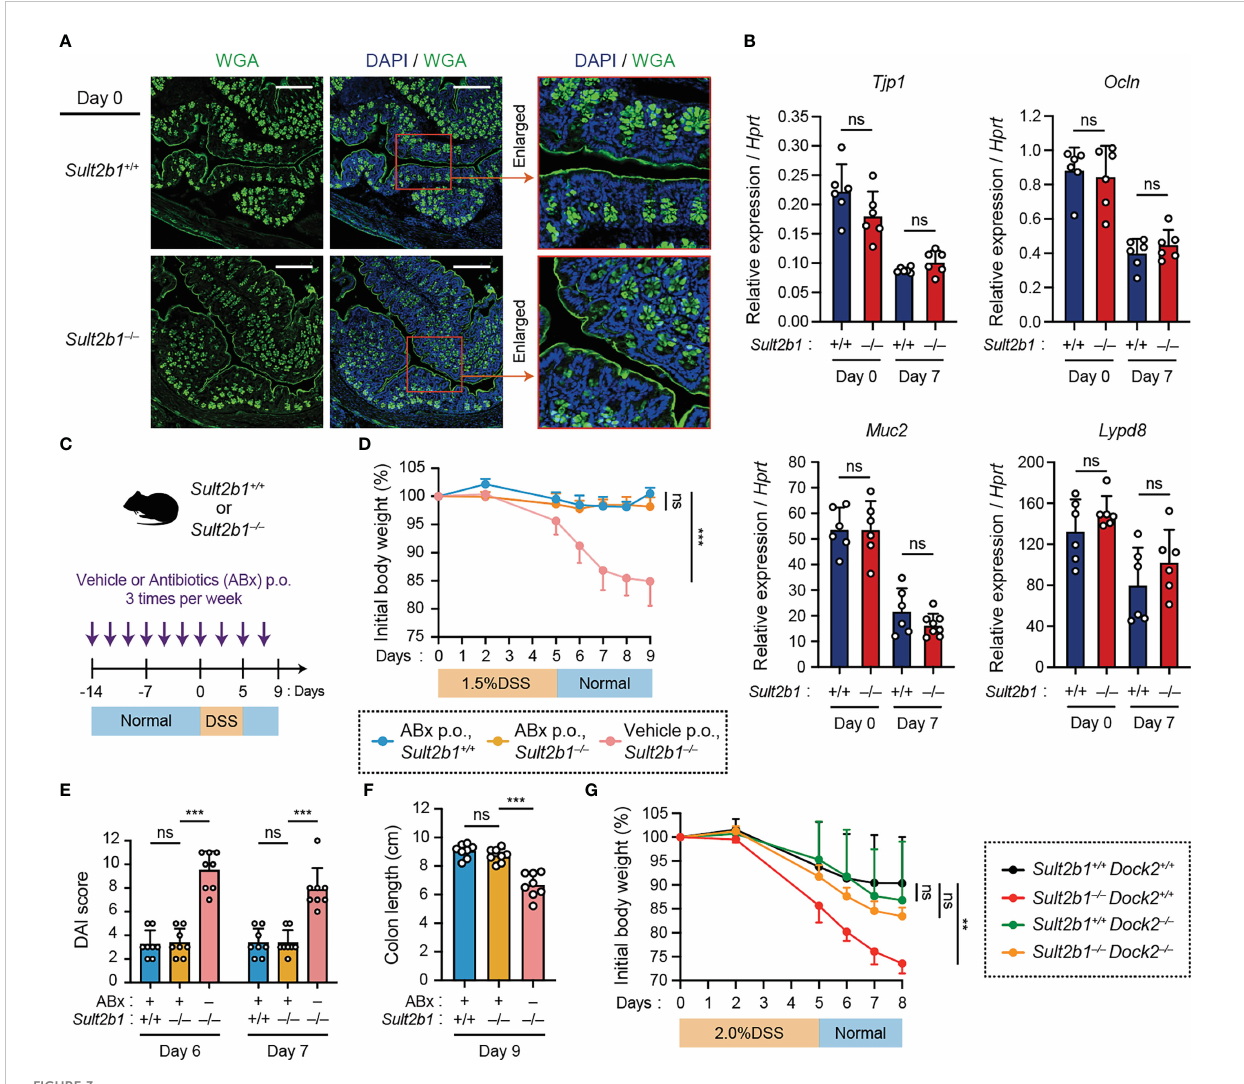
FIGURE 3 Lack of CS does not exacerbate colitis in the absence of intestinal bacteria or by the genetic deletion of Dock2. (A) Representative images showing the colon tissue of Sult2b1 +/+ mice (top) and Sult2b1 − / − mice (bottom) at steady state. Samples were stained using Alexa Fluor ™ 488-conjugated wheat germ agglutinin (green) and DAPI (nucleus; blue). Scale bar, 200 m m. (B) Real-time PCR analysis of the indicated gene expression in the entire colon of Sult2b1 +/+ and Sult2b1 − / − mice on days 0 and 7 after a 5-day 1.5% DSS challenge (n = 7 mice per group; two-tailed unpaired Student ’ s t -test). Target gene expression was normalized to Hprt expression. (C) Schematic illustration of the protocol used for antibiotic treatment. A mixture of